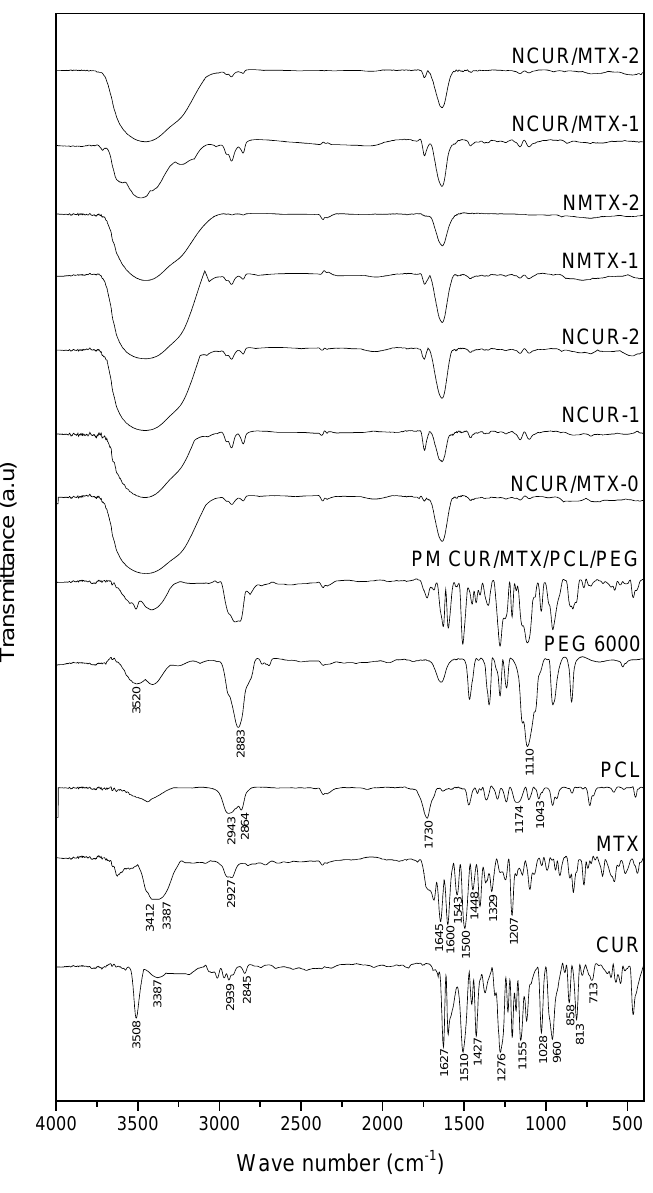
Figure 3. FTIR spectra of CUR, MTX, PCL, PEG 6000, physical mixture, and CUR and / or MTX-loaded and non-loaded NCs.